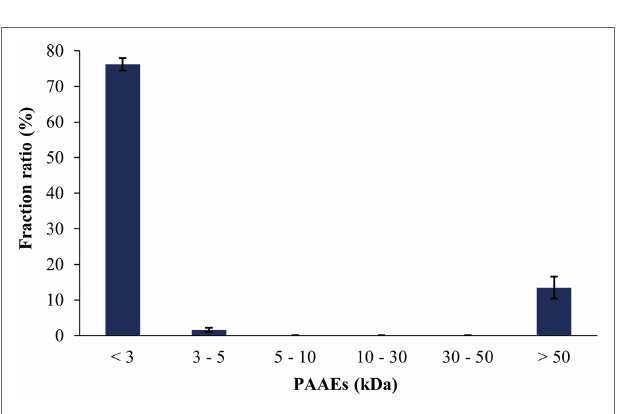
FIGURE 3 | The fraction ratios of gastrointestinal environment-resistant earthworm peptides were permeated through the molecular weight cutoffs (MWCO) of 50, 30, 10, 5, and 3 kDa membranes. The results were expressed as mean with SD of triplicates from three independent